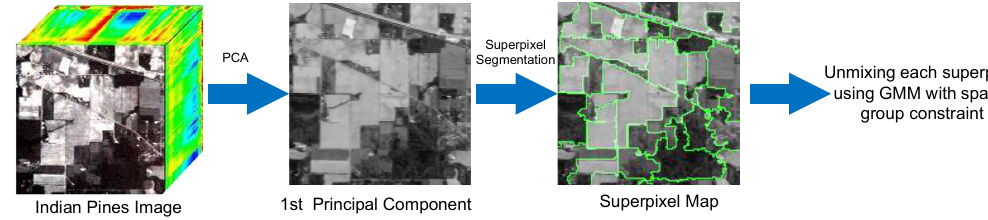
Figure 1. Algorithm flow chart of the proposed spatial group sparsity constraint based on Gaussian mixture model (SGSGMM)